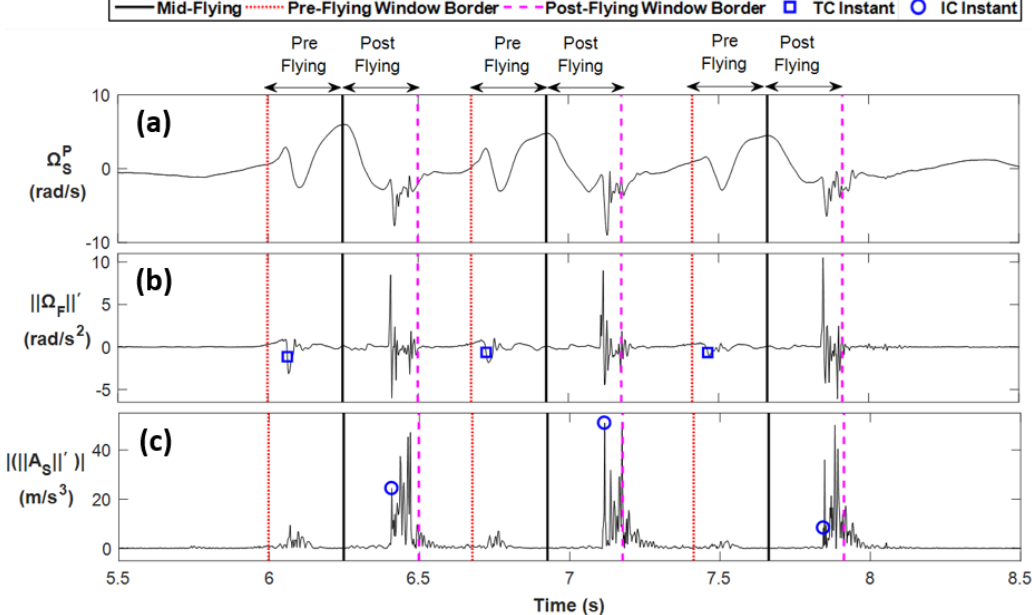
Figure 3. Terminal Contact (TC) and Initial Contact (IC) instants of a typical TSLH trial, detected using IMUs. (a): Mid-flying instants (solid vertical lines) are estimated based on shank pitch angular velocity signal ( Ω 𝑆𝑃 ). Pre-flying (dotted vertical lines) and post-flying (dashed vertical lines) phases are defined 250 ms prior and after the mid-flying instants, respectively. (b): TC instants (shown with squares) are marked on the time-derivative of foot angular velocity norm time-series ( ‖Ω 𝐹 ‖ ′ ). (c): IC instants (shown with circles) are marked on the absolute value of time-derivative of shank acceleration norm time-series ( |‖𝐴 𝑆 ‖ ′ | ).